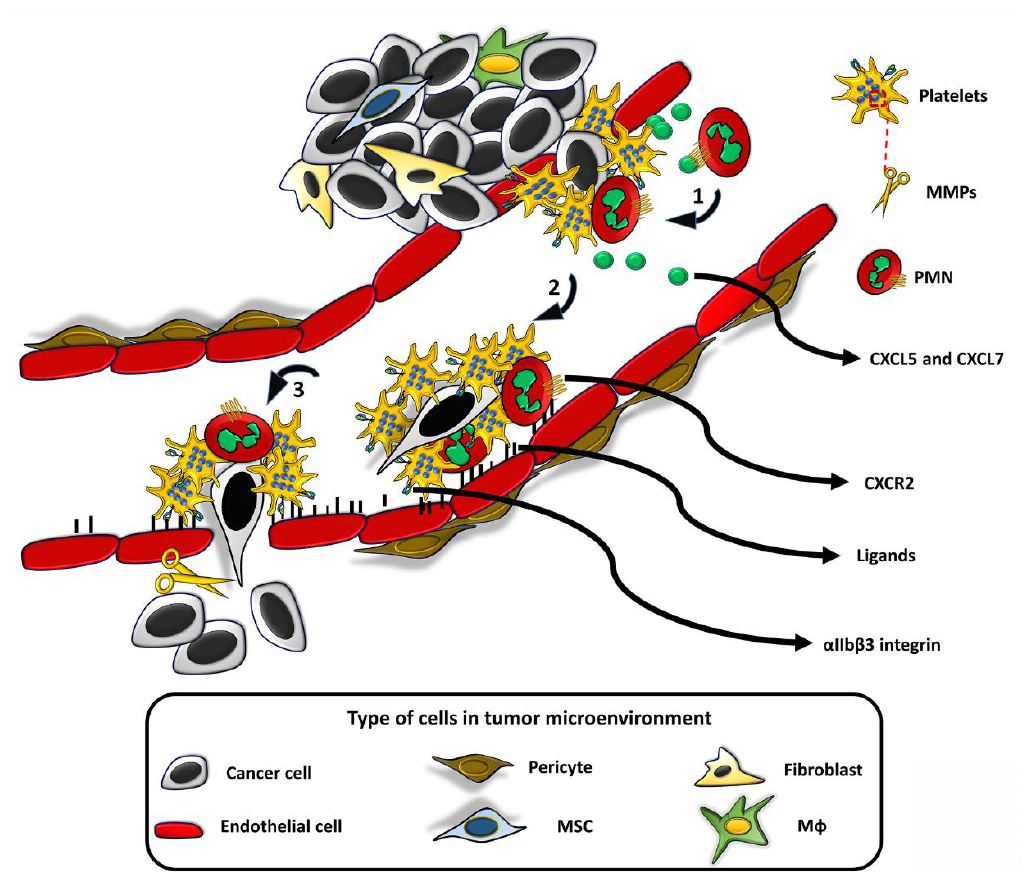
Figure 1. Role of platelets and PMN in metastatic tumor cell dissemination. Tumor cells detach from the primary tumor and invade the circulation. Upon their very first appearance in the blood, tumor cells are recognized as a “thrombogenous surface” thereby activating platelets that encircle and encase tumor cells. Activated platelets release substances stored in their alpha granules, including chemokines CXCL5 and CXCL7 (green spheres in the figure) that interact with CXCR2 receptor of neutrophils which are in turn recruited in the mixed cell agglomerate ( phase 1 in the figure). The binding of neutrophils to platelets is mediated by interaction of the sialyl-Lewis X of neutrophils with P-selectin released by alpha granules and exposed on the platelet surface (41, 46–50). While floating in the circulation ( phase 2 of the figure), a complex mixture of growth factors from platelets induces the shift of tumor cell phenotype from an epithelial to a mesenchymal-like and the mixed agglomerate begins to slow down and to roll on the endothelial surface, exploiting the interaction of P-selectin with PSGL-1 (P-selectin glycoprotein ligand-1) expressed on all the involved cells, including endothelial cells. Multiple interactions are required in this phase (46–50) (various ligands and the many molecules involved on the endothelial side are represented as small black rectangles that project into the blood vessel). The definitive adhesion and stop at the metastatic site ( phase 3 of the figure) occurs between neutrophil integrins, platelet α 2 / β 3-integrin, and P-selectin, with various cell-adhesion molecules (CAM) expressed on endothelial cells. Cell extravasation is facilitated by P2Y2, a purinergic receptor expressed by platelets and endothelial cells: adenine nucleotides released by platelets interact with P2Y2 and “open” the endothelial barrier. Platelets matrix metallo proteinases (MMPs), tumor cell MMPs, and cell-associated fibrinolytic system degrade the extracellular matrix for an irreversible homing of metastatic cells.